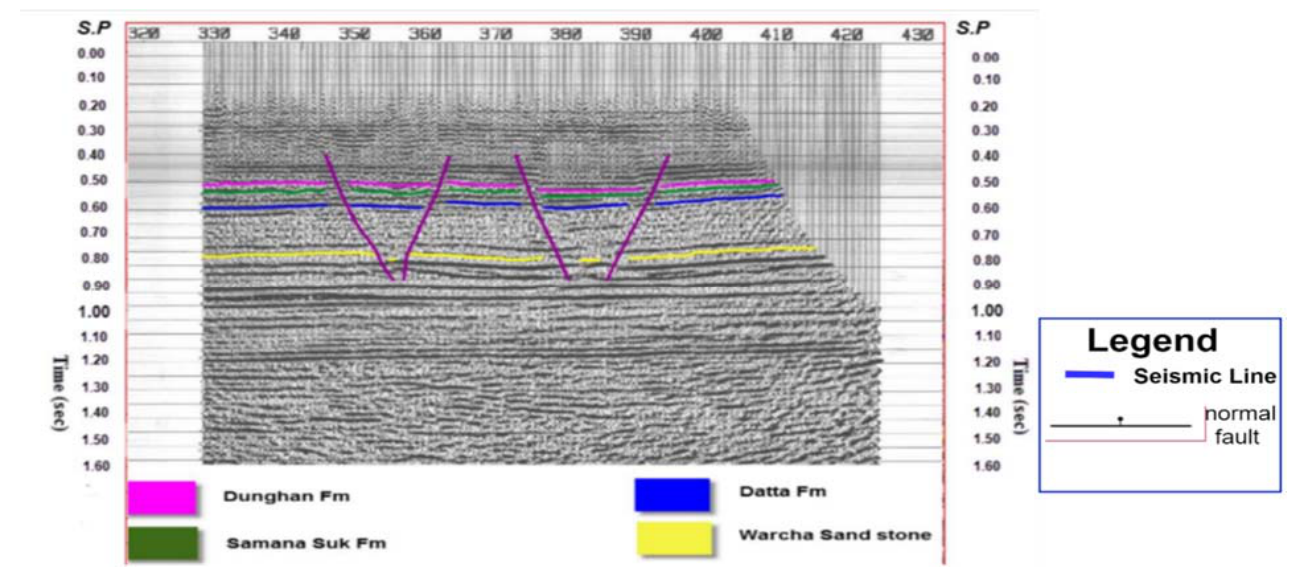
Figure 3. Marked seismic horizons of 875-KBR-220 line.